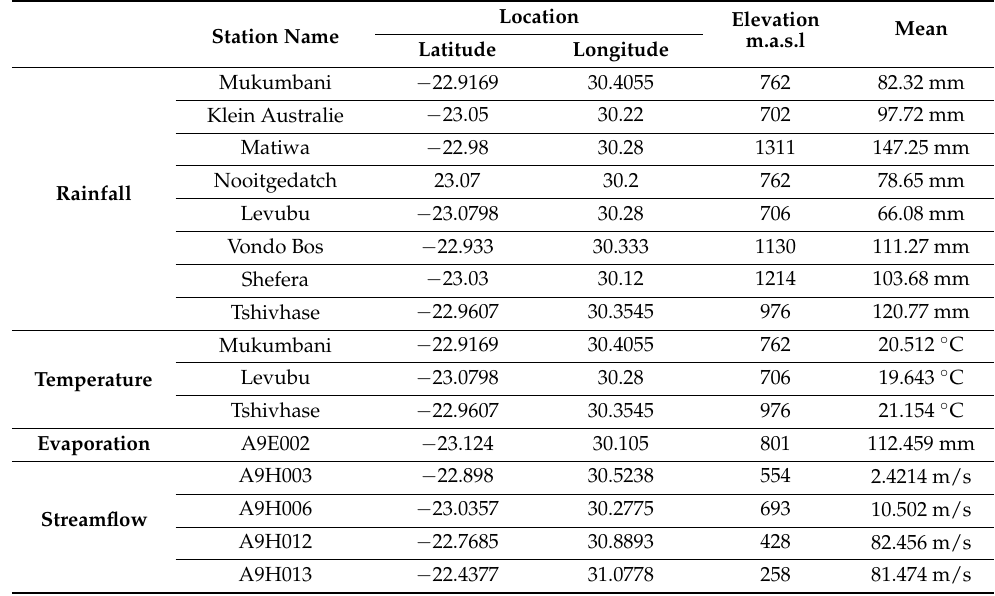
Table 1. Location and other characteristics of the respective datasets used in the